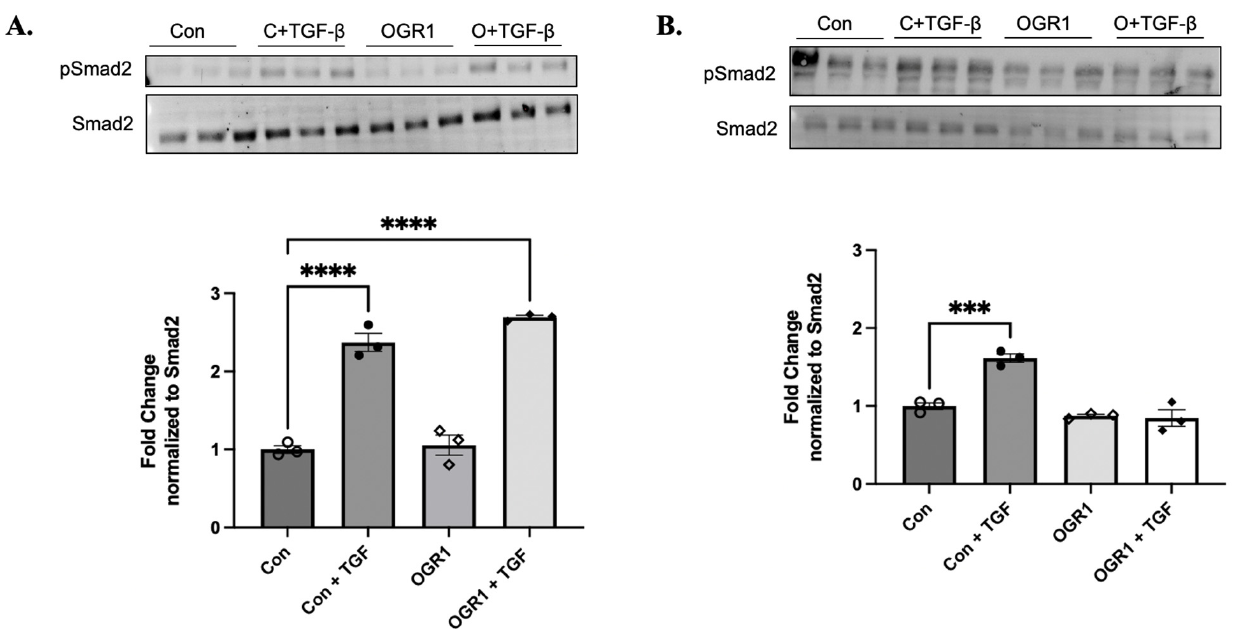
Figure 8. OGR1 does not inhibit Smad2 phosphorylation in 16-HBEs but does so in fibroblasts. Here, 16-HBE cells were transfected with either GFP or OGR1 plasmids and subsequently treated with TGF- β . Canonical TGF- β signaling was then assessed by western blot, examining changes in phos- phorylated Smad2 relative to total Smad2. Although TGF- β significantly increased phosphorylated levels of Smad2 ( A , **** p < 0.0001), overexpression of OGR1 was unable to mitigate TGF- β -induced Smad2 phosphorylation ( A , **** p < 0.0001). Fibroblasts underwent identical transfection and treatment, and TGF- β significantly increased Smad2 phosphorylation ( B , *** p = 0.0007). However, in the presence of OGR1 overexpression, TGF- β was unable to phosphorylate Smad2 ( B , difference between Con and OGR1 + TGF- β , p = 0.0031 by Student’s t -test). Data represent mean expression ± SEM. Open circles represent control plasmid and closed circles represent control plasmid plus TGF- β . Open diamonds represent OGR1 plasmid and closed diamonds represent OGR1 plasmid plus TGF- β .